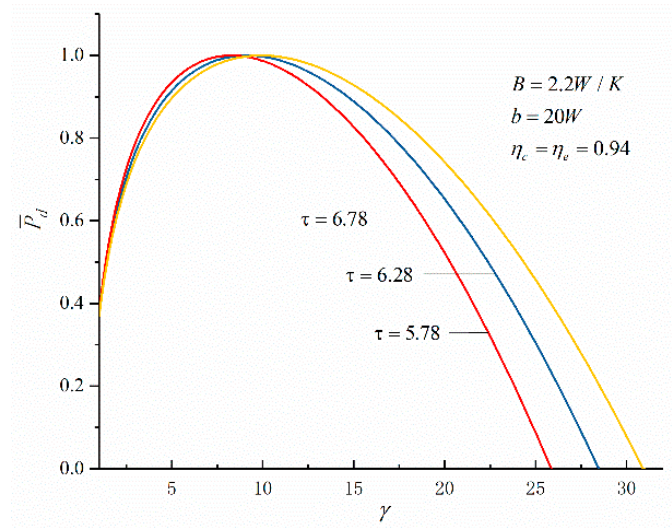
Figure 2. The curves of P d − γ about τ .